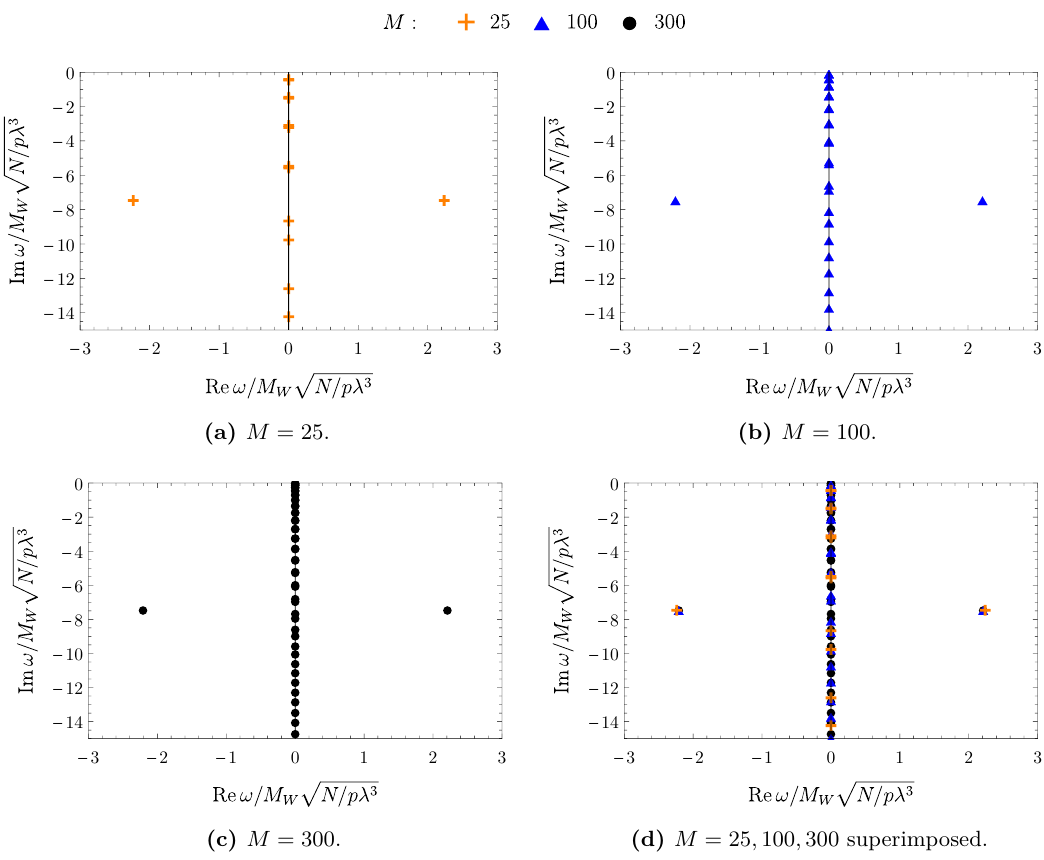
p Figure 2. QNM frequencies at l = 0 , in units of M W N/pλ 3 . The frequencies were computed numerically using Leaver’s matrix method, detailed in appendix A. The different symbols and colours correspond to different matrix sizes M : orange crosses to M = 25 , blue triangles to M = 100 , and black dots to M = 300 . (a, b, c): QNM frequencies computed with these different values of M . For all matrix sizes we observe a pair of modes with equal and opposite Re ω 6 = 0 , and Im ω < 0 . The frequencies of these QNMs computed with M = 300 are given in eq. (4.3). We also observe many poles on the negative imaginary axis, which become denser as we increase M , consistent with a branch cut. (d): the results for our three different M values, superimposed. The isolated modes do not appear to move as we increase M , indicating good convergence of our numerical